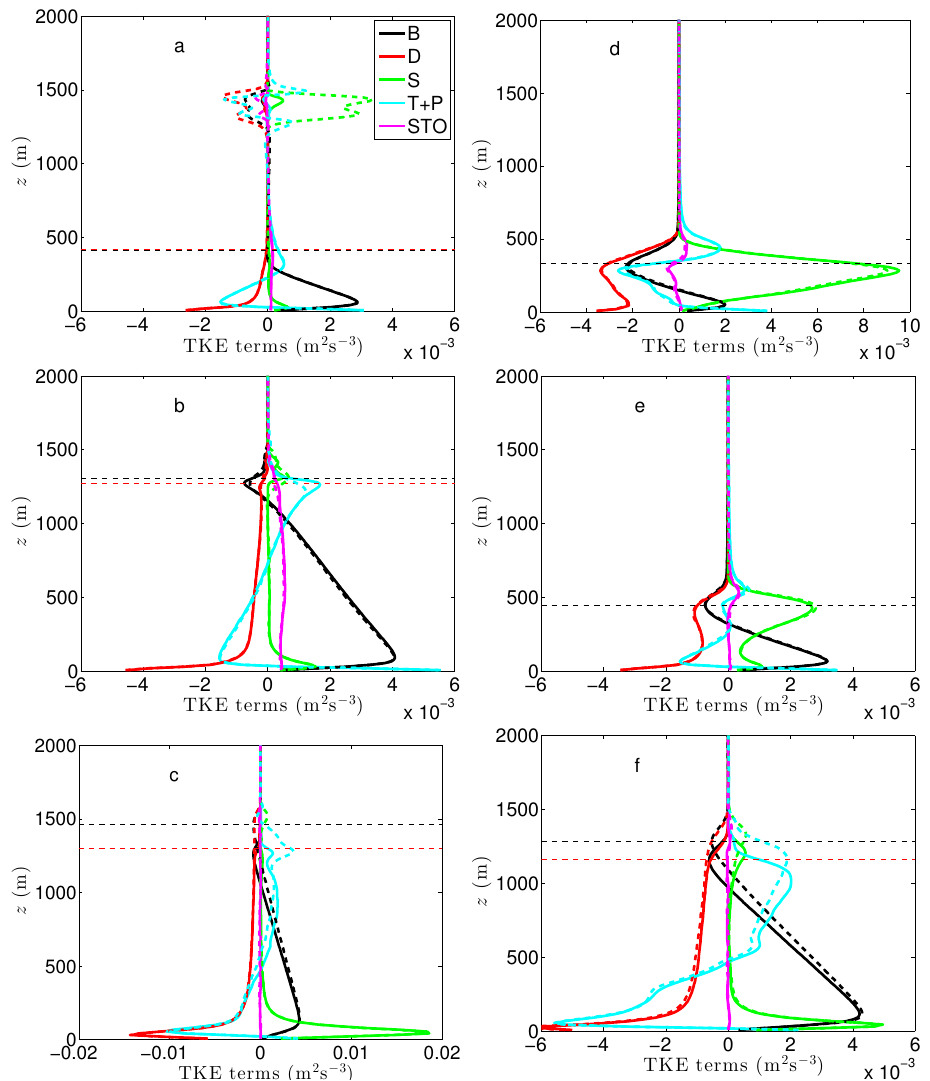
Fig. 7. Vertical profiles of the 30-min averaged TKE terms for the (left) RLns (dashed lines) and RLs (solid lines) and (right) nRLs (solid lines) and nRLns (dashed lines) numerical experiments at 08:30 (top), 09:00 (middle), and 14:00UTC (bottom). Buoyancy production (black line), dissipation (red line), shear production (green line), turbulent transport and pressure (cyan line) and storage (magenta line) are shown. Red and black horizontal dashed lines mark the subsidence and no-subsidence cases z 1 averaged every 30min.